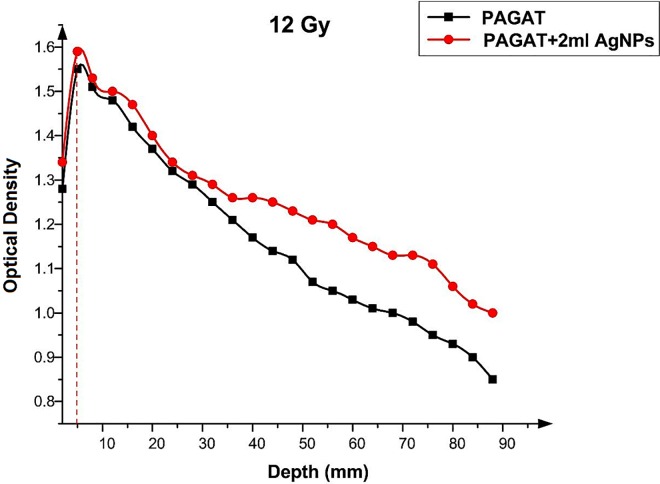
OD versus depth in the PAGAT polymer gel and PAGAT with Ag nanoparticles iraddiated by 12 Gy of 60Co.